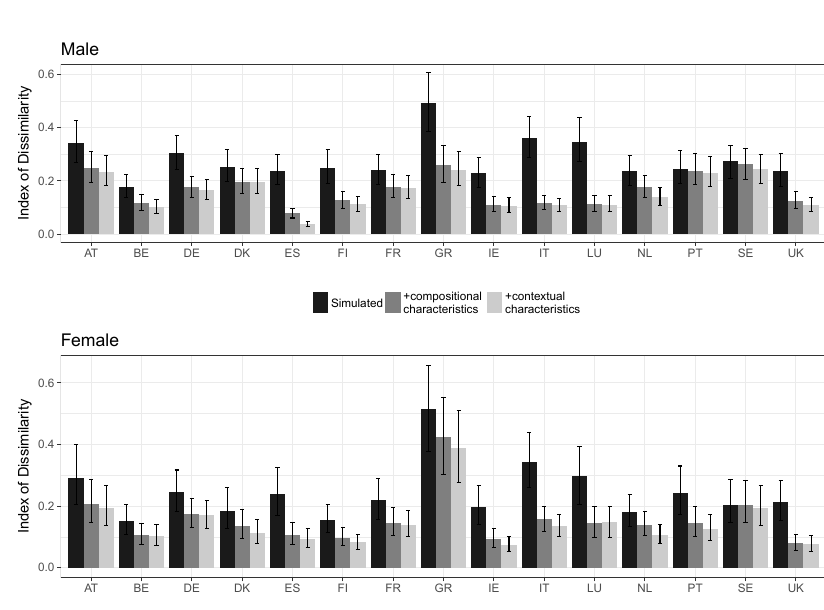
Figure 2 Ethnic occupational segregation in EU-15 countries based on multi- level simulation